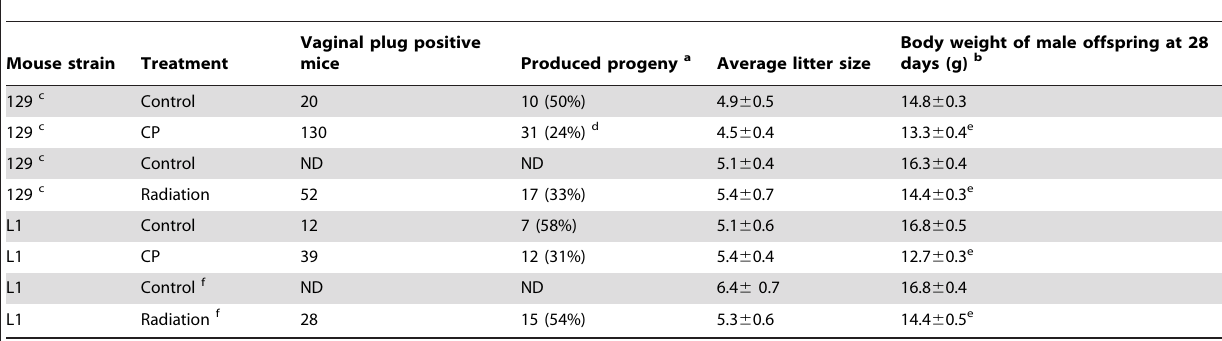
Table 1. Effect of cyclophosphamide (CP) or radiation on days 10.5 and 11.5 after mating on breeding efficiency of 129 and L1 mice.